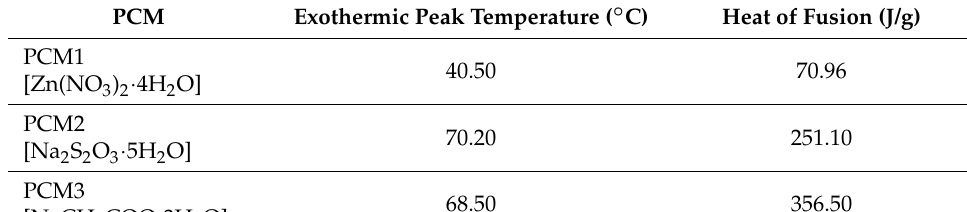
Table 3. DSC experimental results for exothermic capacity for the inorganic PCMs used.